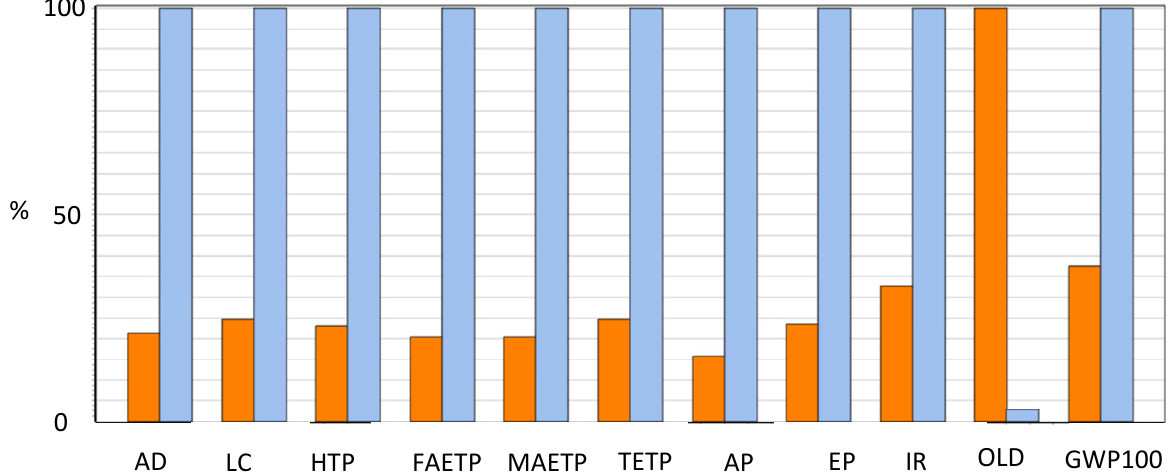
Figure 9. Midpoint indicators for PEMFC (Orange) and AEMFC (Light blue). AD = Abiotic Depletion (for elements, reverse base); LC = Land Competition; HTP = Human Toxicity Potential 100a; FAETP = Freshwater Aquatic Eco Toxicity Potential 100a; MAETP = Marine Aquatic Eco Toxicity Potential 100a; TETP = Terrestrial Eco Toxicity Potential 100a; AP = Acidification Potential (fate not incl.); EP = Eutrophication Potential (incl. fate); IR = Ionising Radiation; OLD = Ozone Layer Depletion (incl. NMVOC av.); GWP = Global Warming Potential 100a (incl. NMVOC av.).